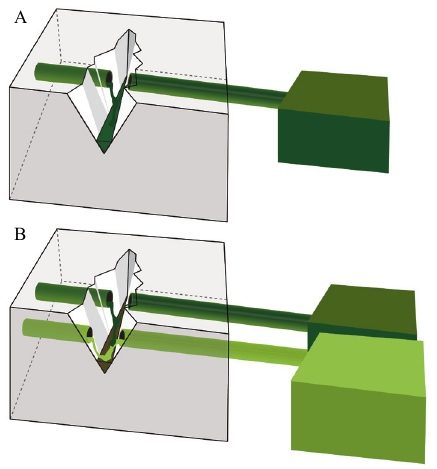
Figure 4. Vascular based self-healing approaches. Leakage of healing agent from the tank via the vascular into the crack due to gravitational and capillary forces and eventual (hydrostatic) pressure. One-channel ( A ) and multiple channel vascular system ( B